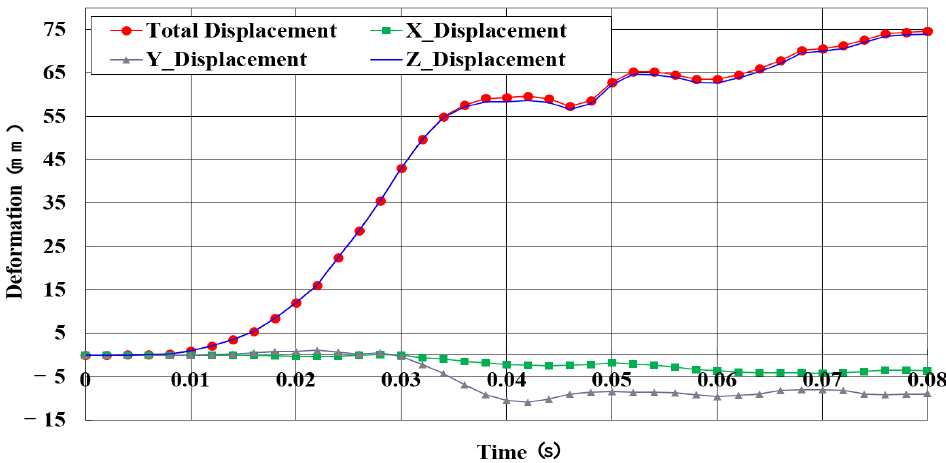
Figure 6. Time history results of maximum